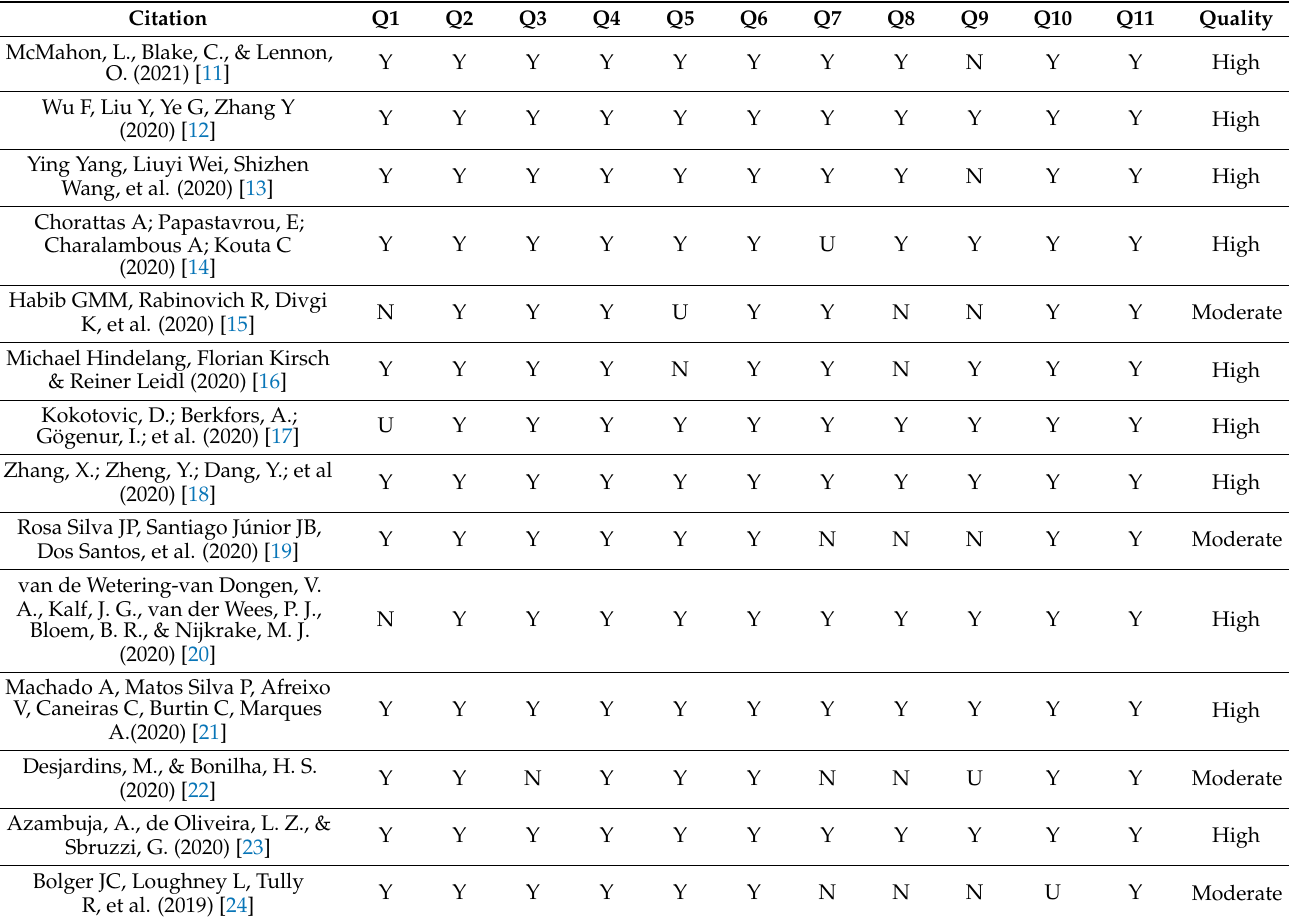
Table 1. Critical appraisal results of eligible systematic